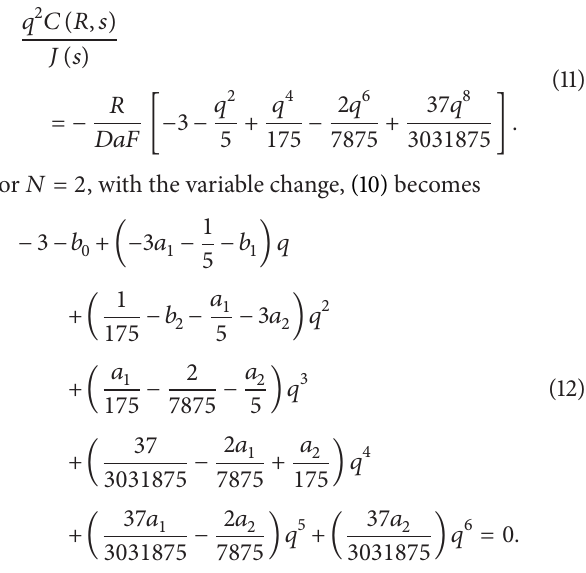
Figure 1: Transfer functions for a one-dimensional model of the solid-statediffusioninatypicalelectriccarbatterycell.Bothtransfer functions are moving away from the singularity at 𝑠 = 0 . On discharge, as the electron output of the anode moves toward zero, the input into the cathode increases, making its transfer function decrease.